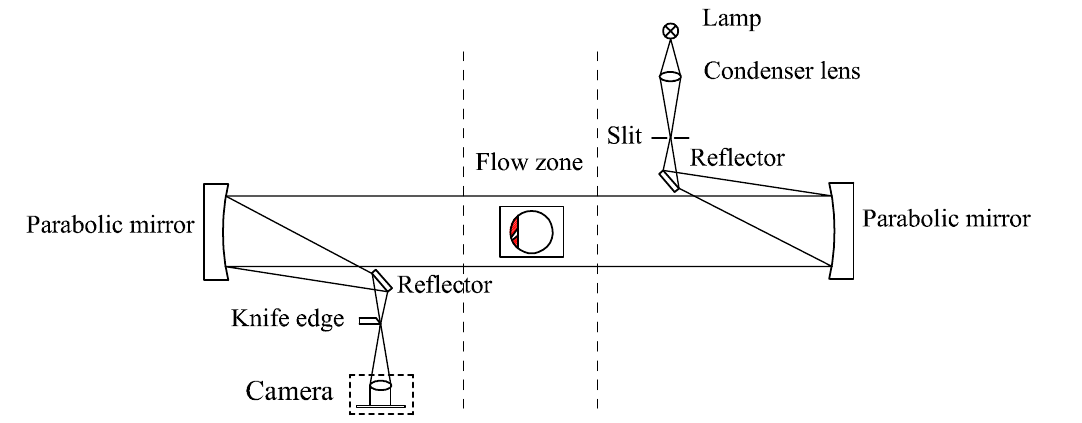
Figure 3. Schematic of the Schlieren system.